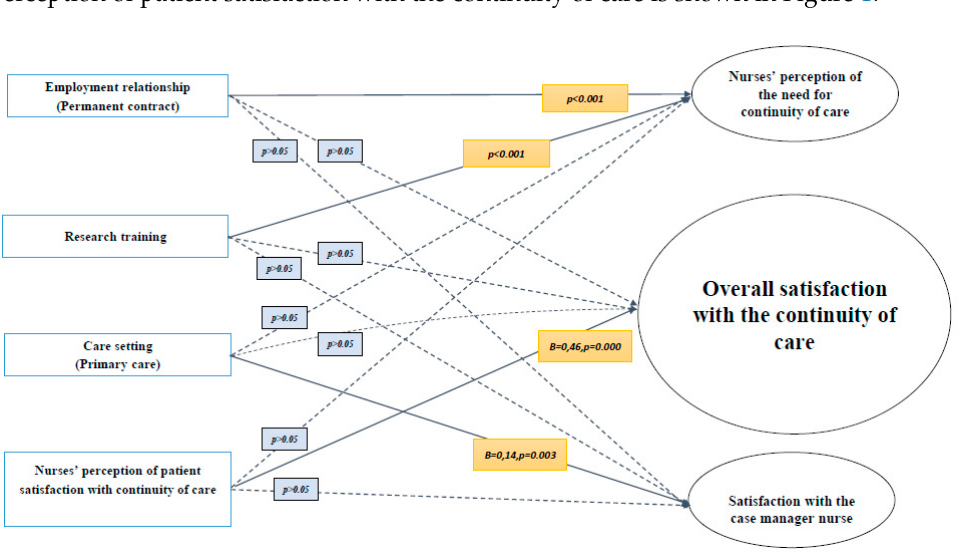
Figure 1. Nurse satisfaction regarding the continuity of care and case management